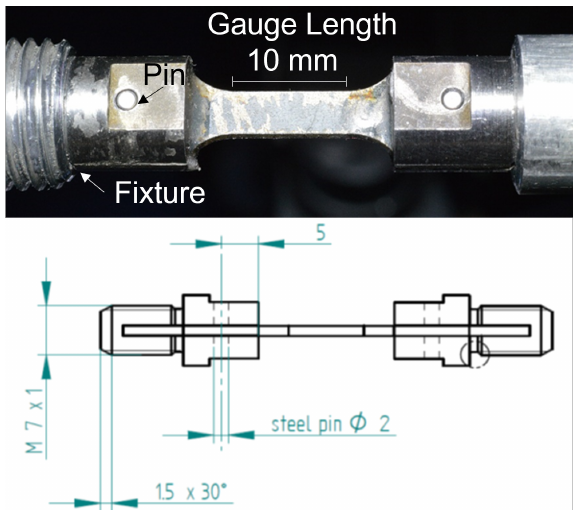
Figure 1. Hopkinson bar flat dog bone-shaped specimen and fixture